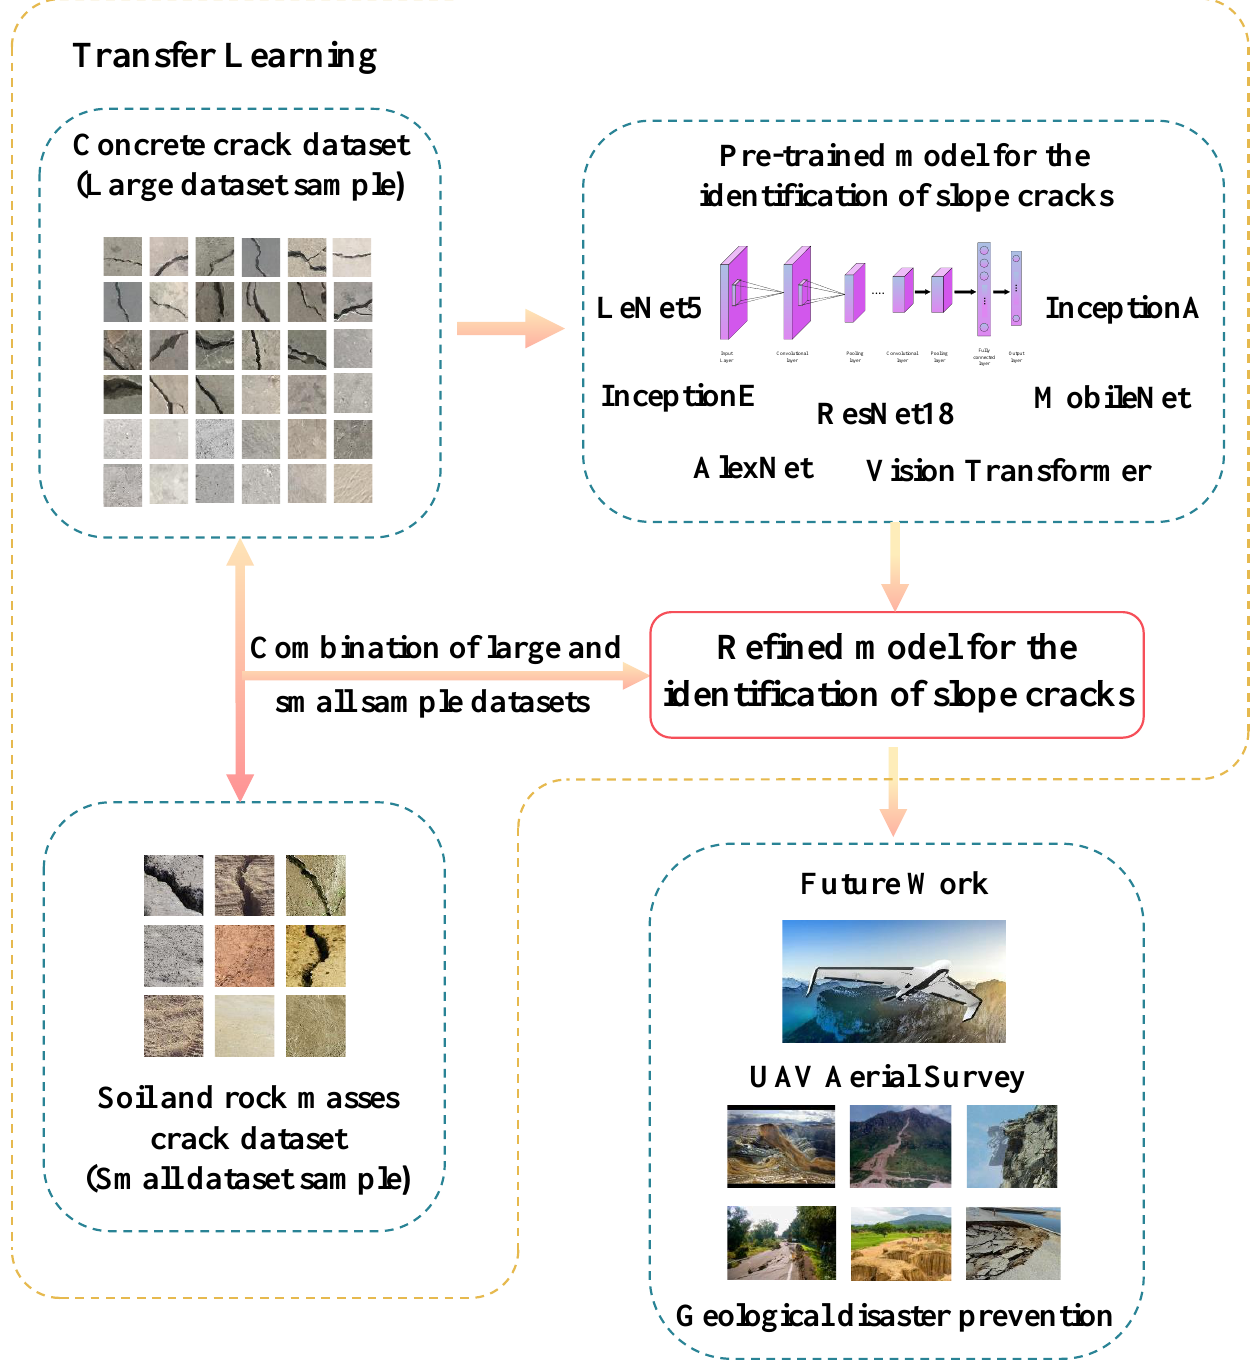
Figure 3. Workflow of the proposed deep learning approach for the identification of slope surface cracks. Step 2 : Sorting out and labeling the dataset of surface cracks in soil and rock masses. Using a transfer learning strategy to obtain refined deep learning models for the identifica- tion of slope surface